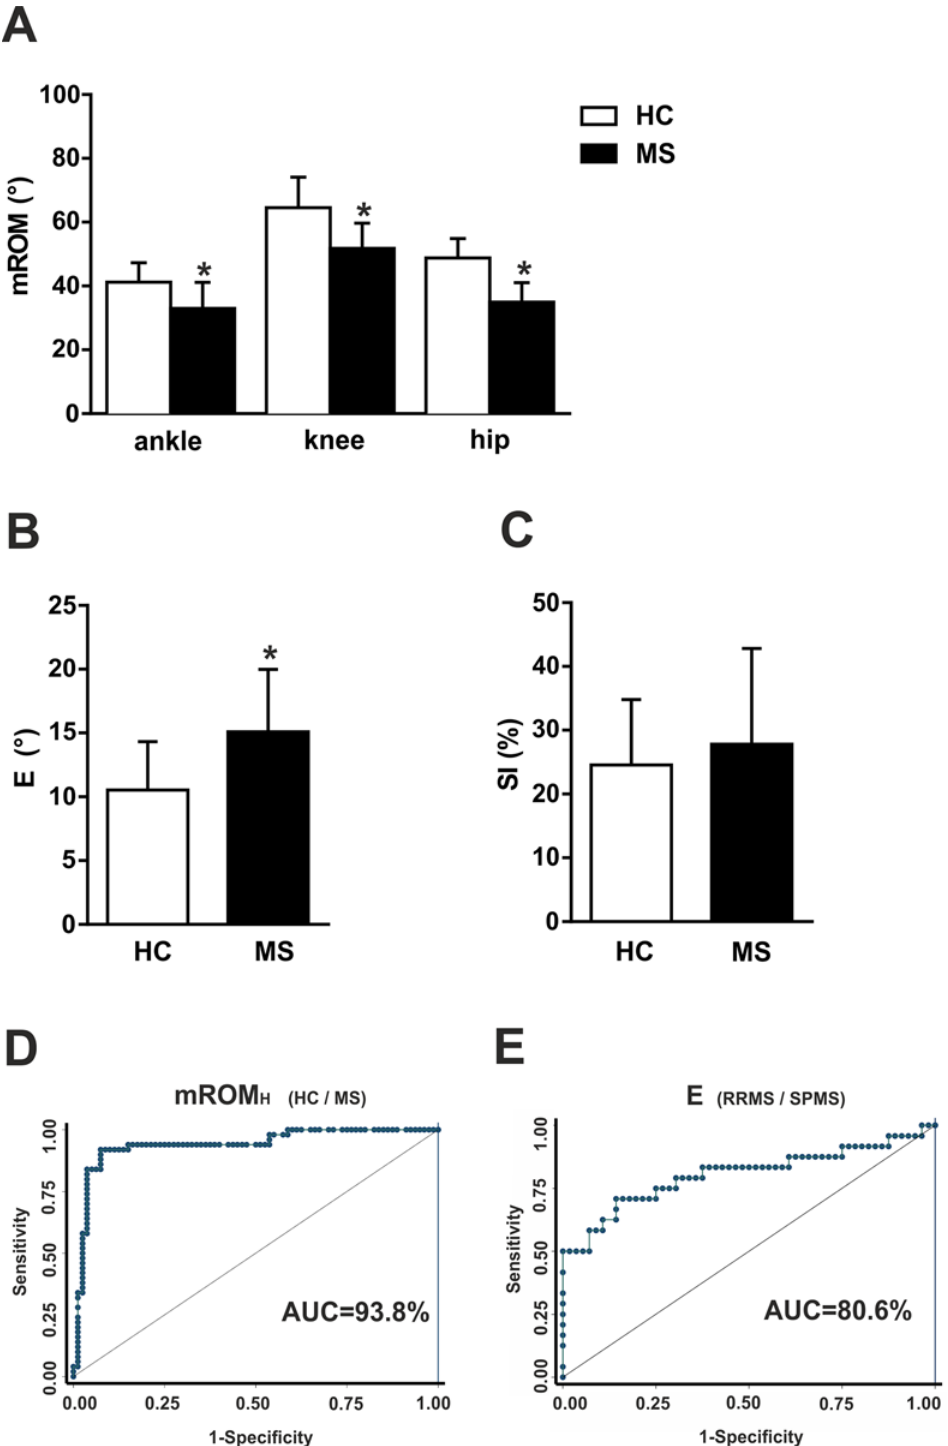
Fig 2. Lower limb kinematics alterations in MS patients. Lower limb kinematics alterations in MS patients. (A) The graph shows thatmROM was significantly lower in MS group respect to HC group in each joint. (B) MS patients presented significantly higher variability of gait, as documented by E analysis. (C) SI was not significantly different between MS and HC group. (D), (E) Area under the ROC curves measured the accuracy of mROMH in discriminating HC from MS (D) and the accuracy of E index in discriminating RRMS from SPMS (E). * means p < 0.05.